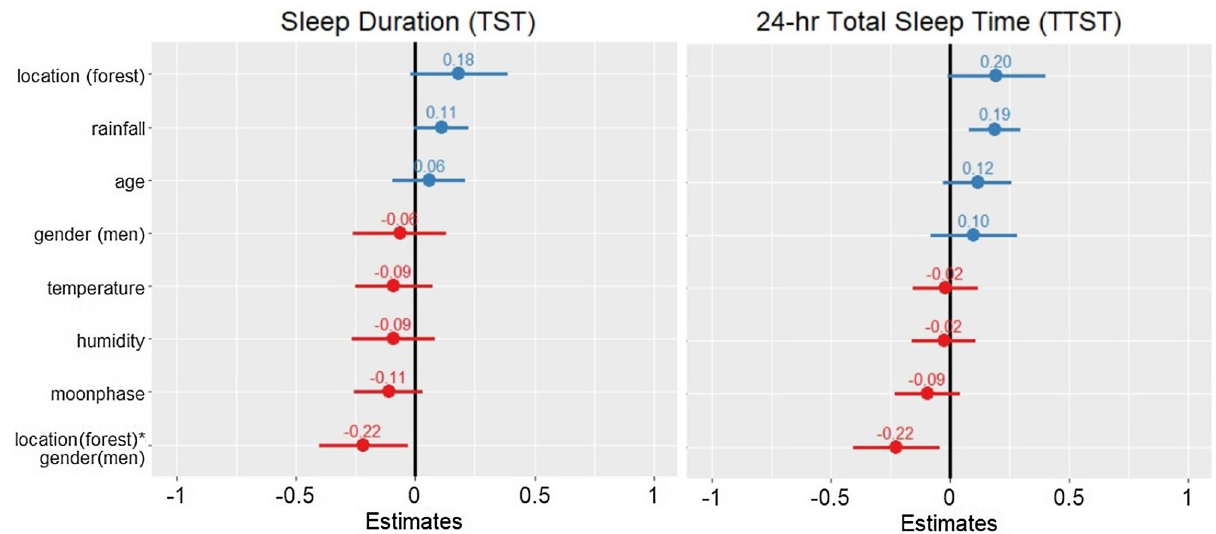
Figure 1. Two fixed effect plots of ecological predictors on sleep duration quotas: nighttime sleep duration (TST) (left) and 24-h total sleep time (TTST) (right). Reference variables are set as village for location, and women for gender for all models. Both plots illustrate positive (indicated in blue) and negative (indicated in red) predictors of TST and TTST. The plotted lines indicate 95% confidence intervals of each predictor variable. For TST, only the location * gender interaction was a significant predictor variable. The location * gender interaction was also a negative predictor of TTST, while rainfall was a positive predictor. Values written above each plotted line are standard estimates of each predictor. Continuous predictors were scaled for comparability of the coefficients in the models.